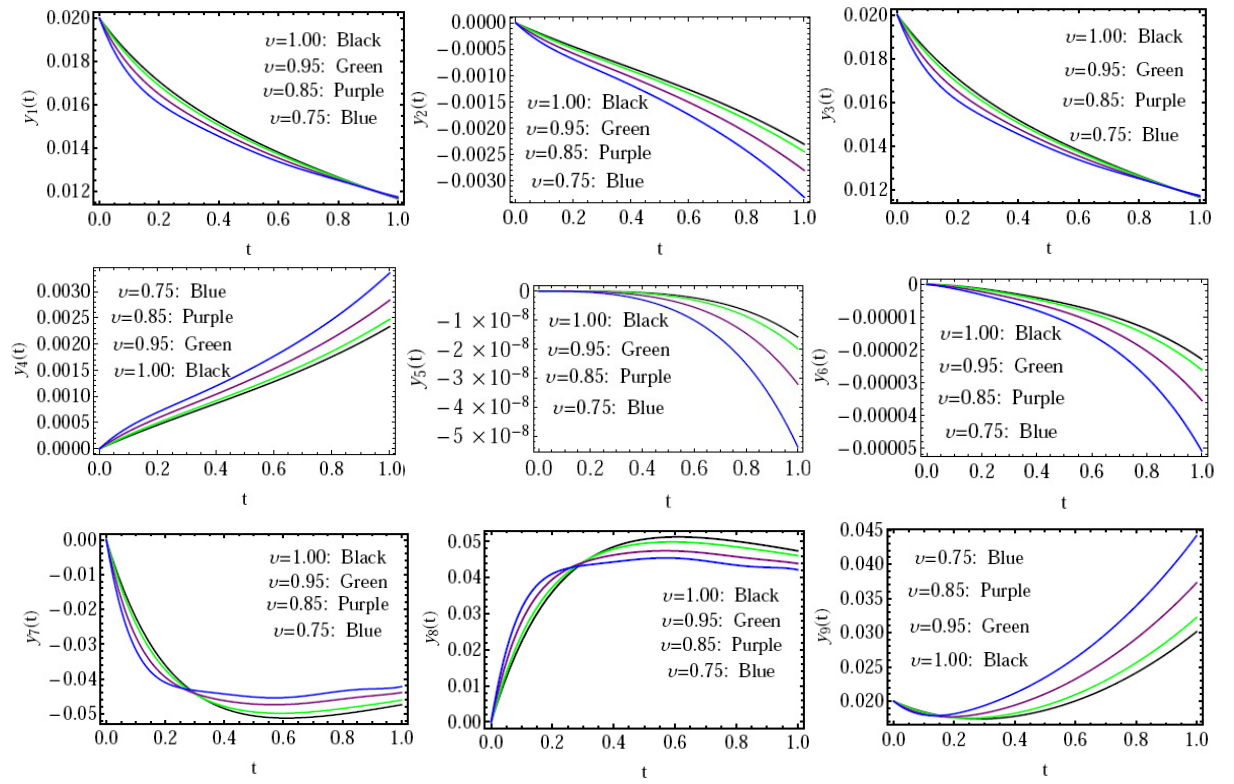
Figure 1. The approximate solution y i ( t ) , i = 1 ( 1 ) 9 against distinct values of ν .